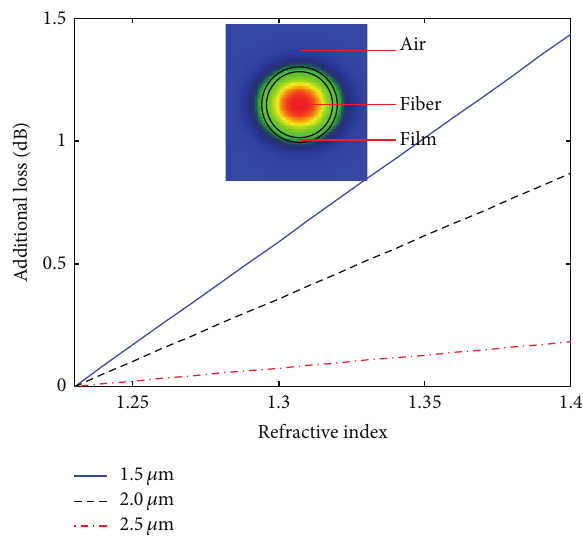
Figure 3: The calculated additional loss caused by contaminants. The inset shows power distribution of a 1.5 𝜇 m diameter microfiber with nanoscale-structured